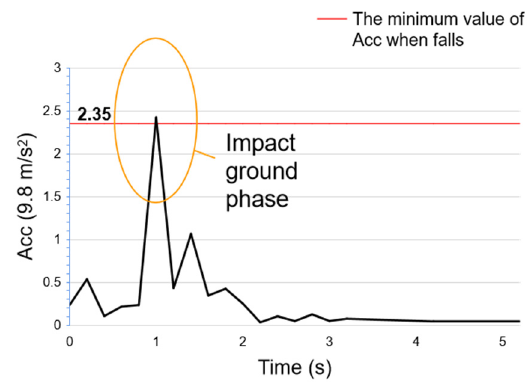
Figure 14. Total acceleration curve of falls.